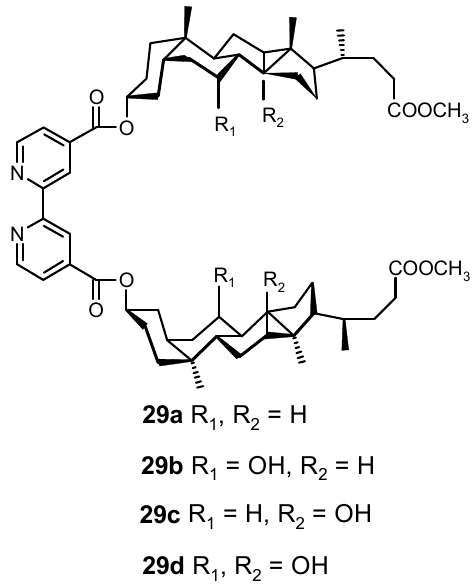
Figure 18. 2,2'-Bipyridine-4,4'-dicarboxylates 29a - d of four bile acid methyl esters [114].